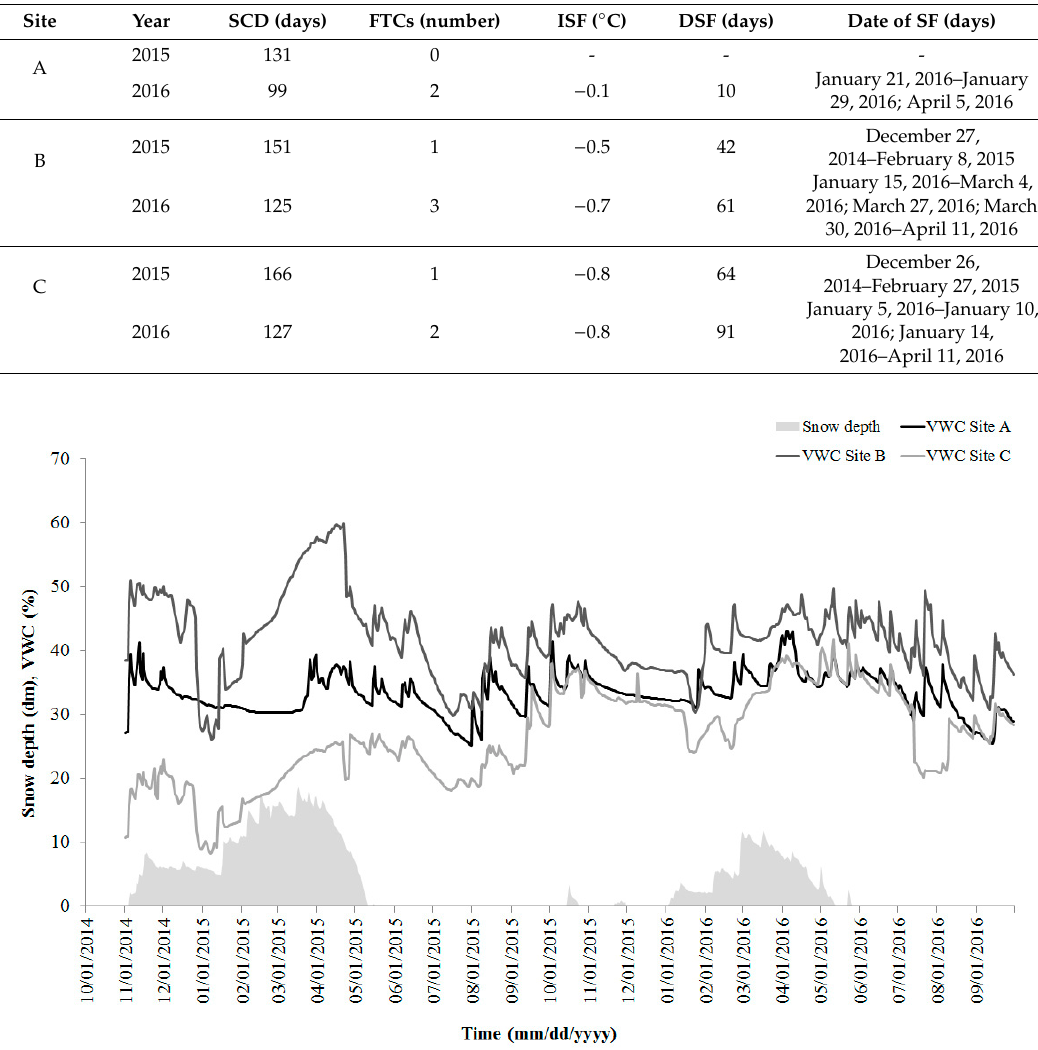
Figure 4. Snow depth (dm, from AMS) and soil VWC (%) in the 3 study sites along the experimental period (from October 1, 2014, to September 30, 2016).